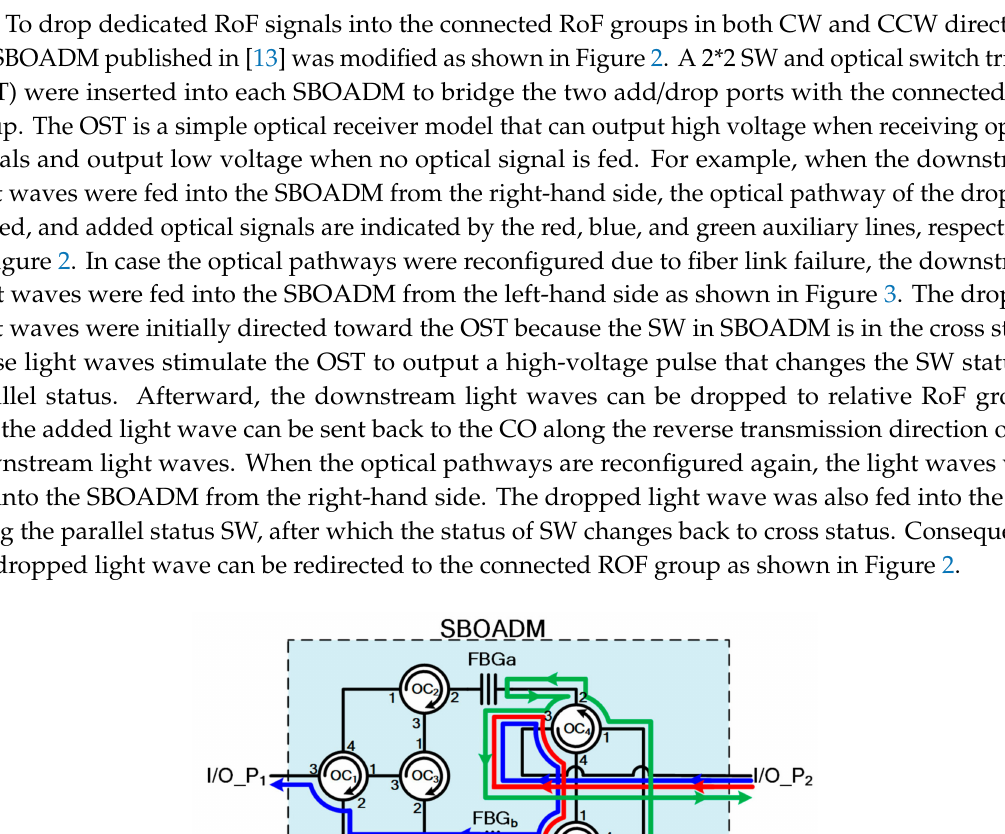
Figure 1. The proposed two-ring based radio over fiber (RoF) transport system with a self-healing functionality.